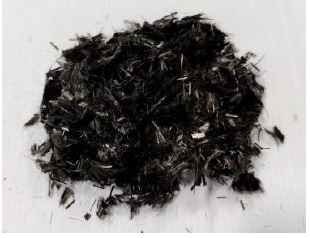
Figure 2. Picture of the carbon